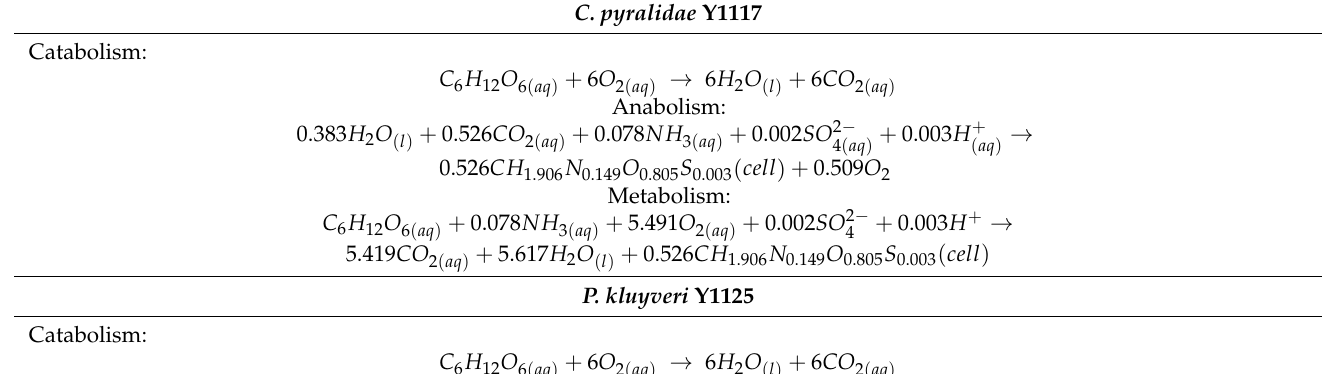
Table 5. Catabolism and anabolism equations for biopreservation compound production per unit glucose used by C. pyralidae Y1117, P. kluyveri Y1125, and P. kluyveri Y1164 using grape pomace extracts as fermentation medium.